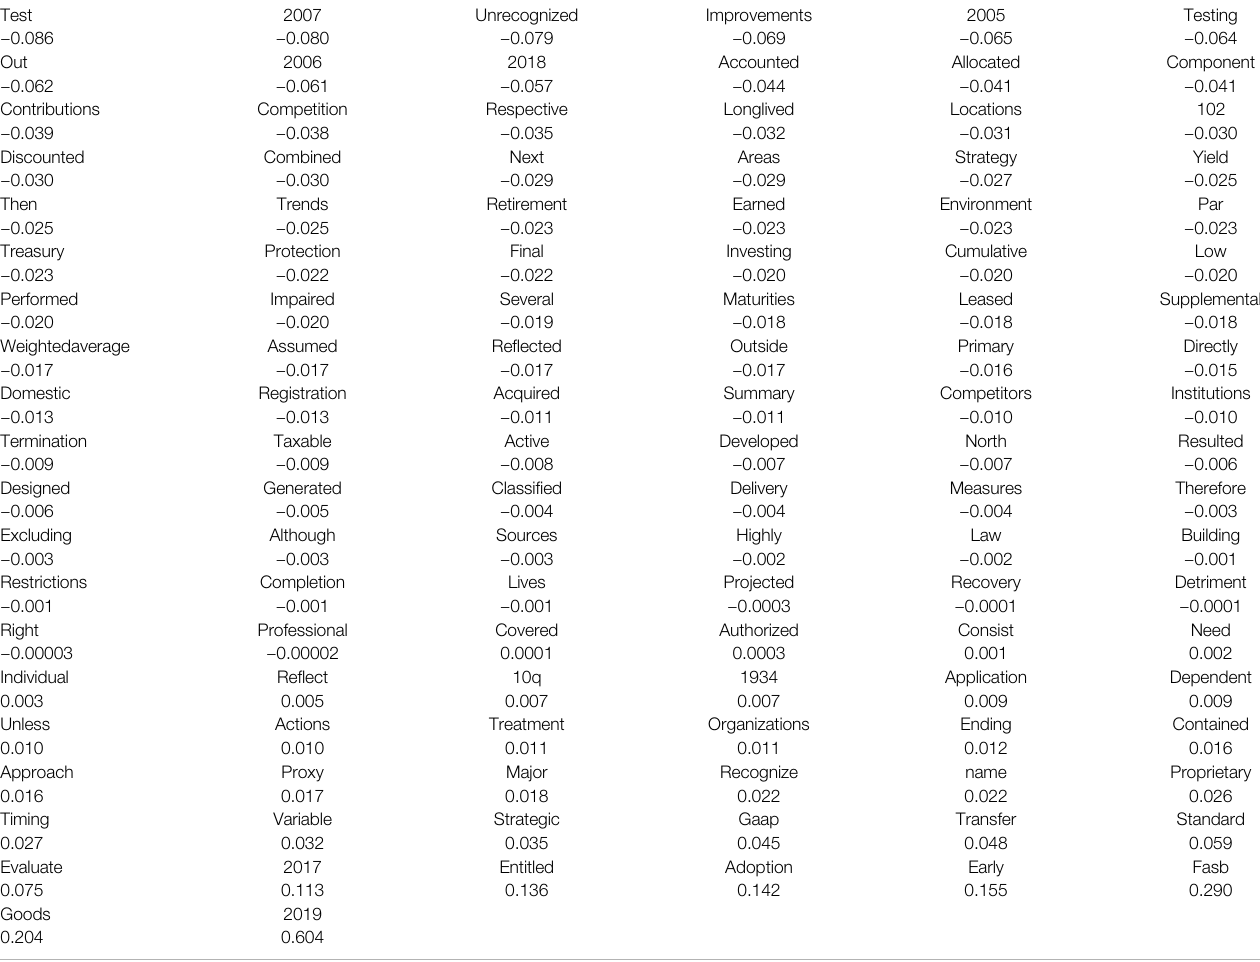
TABLE 4 | LASSO results, Bag of Words